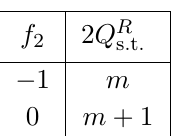
Table 2 . The boundary R-charge of the Ramond ground states for a given value of integers ( m, f 2 ) . The pair of states form an N = 4